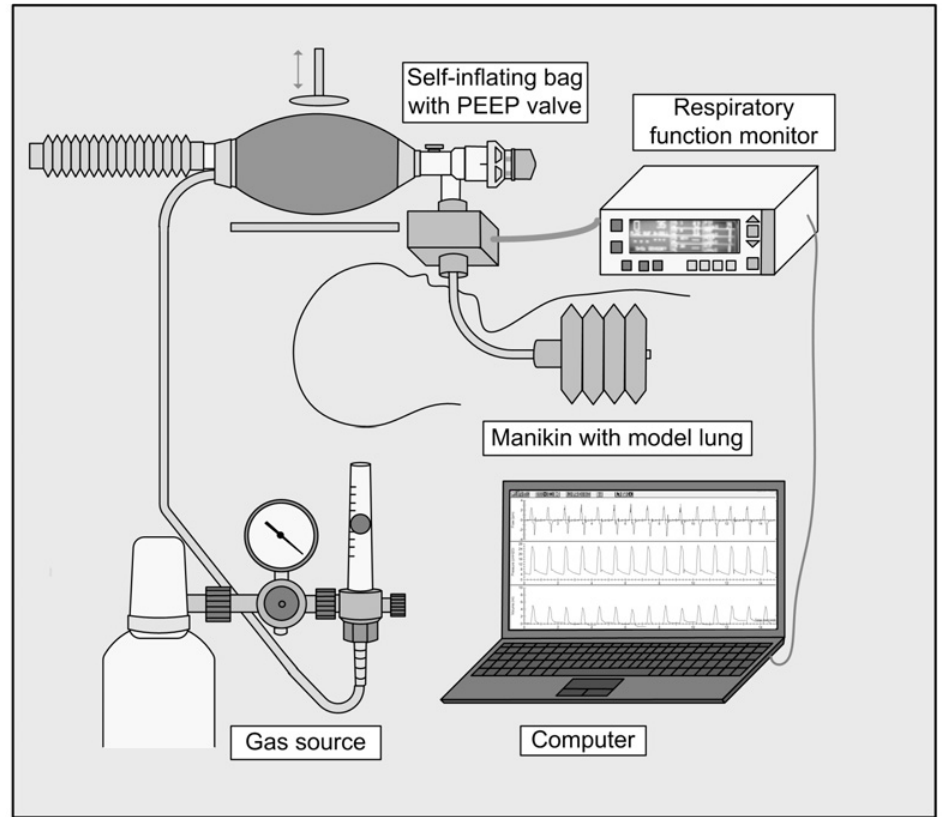
Fig 1. Schematic diagram of the experimental setup: The single-use PEEP valves were consecutively attached to a mechanically driven self-inflating bag. A gas source was connected. Subsequently a manikin simulating a 1kg neonate was ventilated. The delivered pressures and volume were measured using a respiratory function monitor and analyzed with a laptop computer. Standard settings were: Peak inspiratory pressure = 20 cmH 2 O, ventilation rate = 60/min, flow = 8